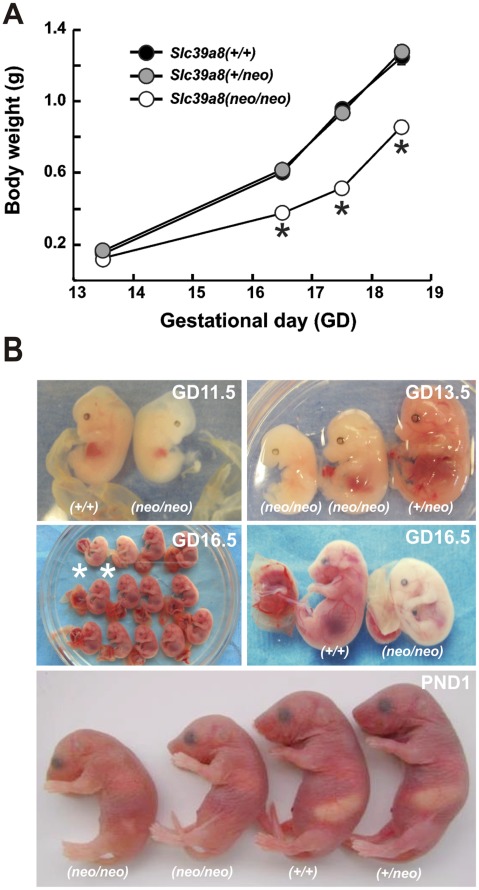
Characterization of Slc39a8(neo/neo) phenotype.(A) Body weight of embryos and fetuses of the three genotypes–from GD13.5 through GD18.5. N = 15–20 per genotype. *
P<0.001, compared with values in Slc39a8(+/+) and Slc39a8(+/neo). In this and subsequent figures, bars and brackets denote means ± S.E.M. Brackets denoting S.E.M. are present in Fig. 1A but are mostly covered up by the size of the symbols. (B) Photographs of (genotyped) Slc39a8(+/+) and Slc39a8(neo/neo) pups at GD11.5 (upper left panel), GD13.5 (upper right), GD16.5 (middle both left & right), and at PND1 (bottom panel). The GD16.5 fetuses (middle left) represent a single litter of 13 pups; the two asterisks in middle left panel denote Slc39a8(neo/neo) homozygotes; the other 11 were Slc39a8(+/+) wild-type and Slc39a8(+/neo) heterozygotes.